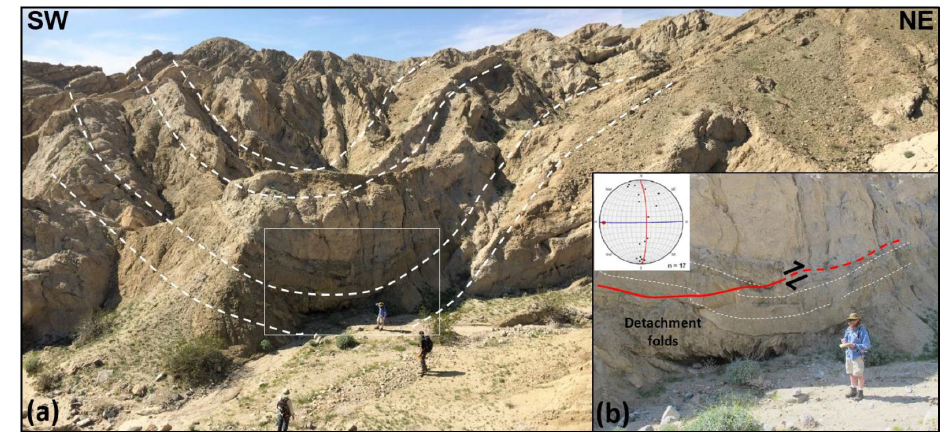
Figure 4. Meso-scale folds and related faults on the back limb of the southeastern macro-fold. See location in Fig. 3c. (a) Syncline in upper Palm Spring Formation units adjacent to the SAFZ-parallel macro-fold near the Indio Hills fault. (b) Close-up view of the synclinal fold hinge in (a) , where a meter-thick sandstone bed is slightly offset by a minor low-angle thrust fault (red line) with NE-directed sense of shear. The minor thrust faults die out in the overlying sandstone bed. The mudstone bed below acts as a décollement layer with internal plastically folded lamination, including disharmonic intra-detachment folds. Structural orientation data of minor centimeter-scale fold limbs in the décollement zone are plotted in a lower hemisphere Schmidt stereonet, indicating E–W-trending fold axes and a sub-horizontal axial surface (average great circle in red and fold axis as a red